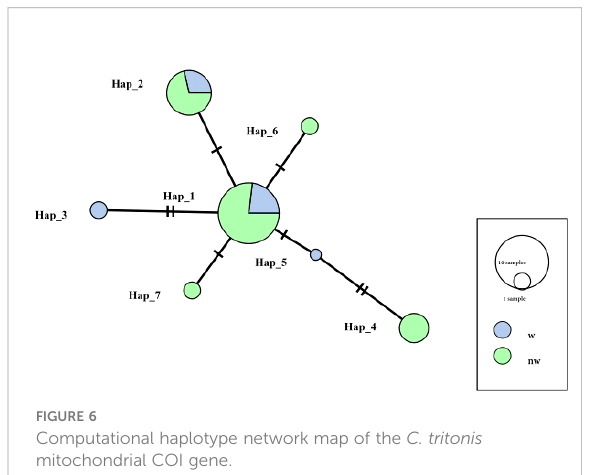
FIGURE 6 Computational haplotype network map of the C. tritonis mitochondrial COI